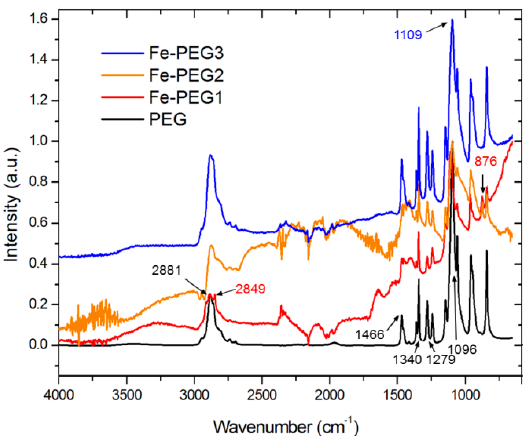
Figure 4. FT-infrared spectra of pure PEG (black line, bottom) and the Fe-PEG composites (in order from bottom to top: Fe-PEG1—red line, Fe-PEG2—orange line, Fe-PEG3—blue line).